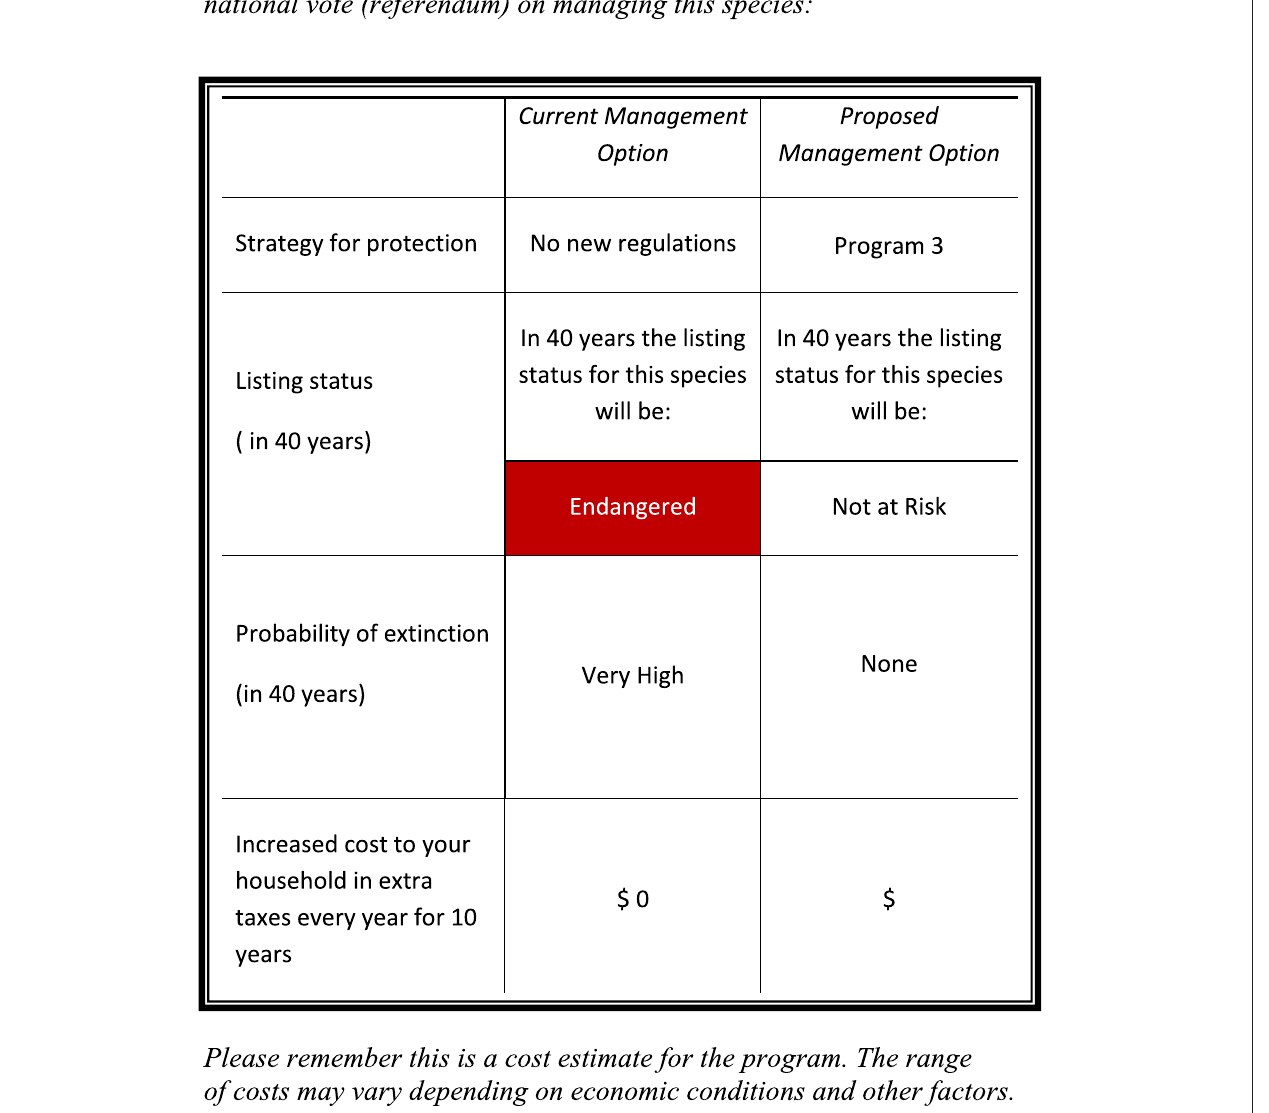
FIGURE 1 | Survey question example comparing Program 3 to the status